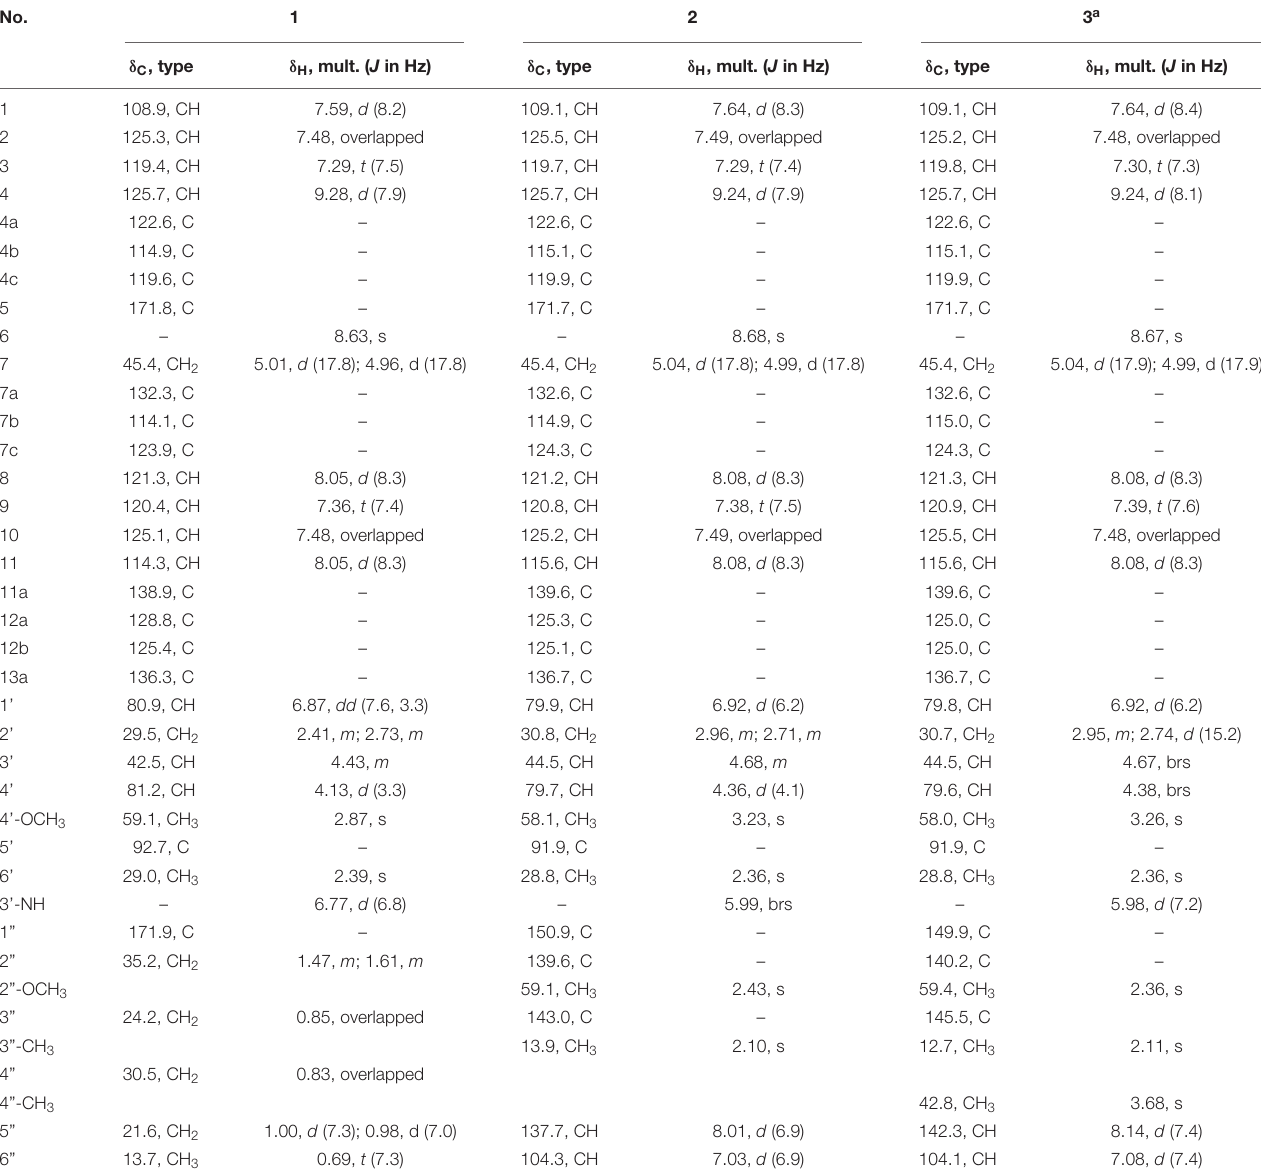
TABLE 1 | 1 H (500 MHz) and 13 C NMR (125 MHz) data for compounds 1 – 3 in DMSO- d 6 .